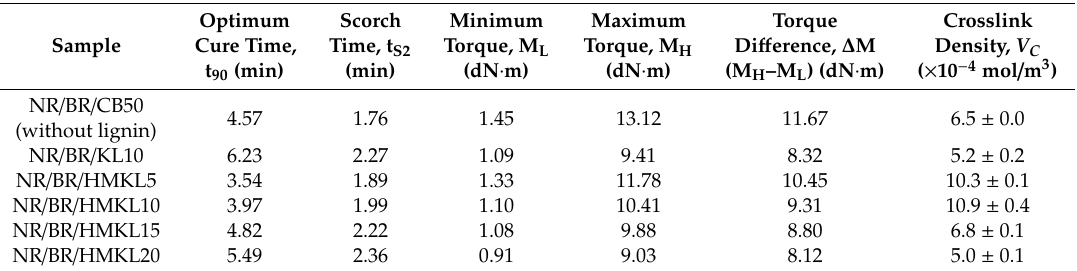
Table 2. Curing characteristics and crosslink density of NR / BR / kraft lignin (KL) compared to NR / BR / hydroxymethylated kraft lignin (HMKL)